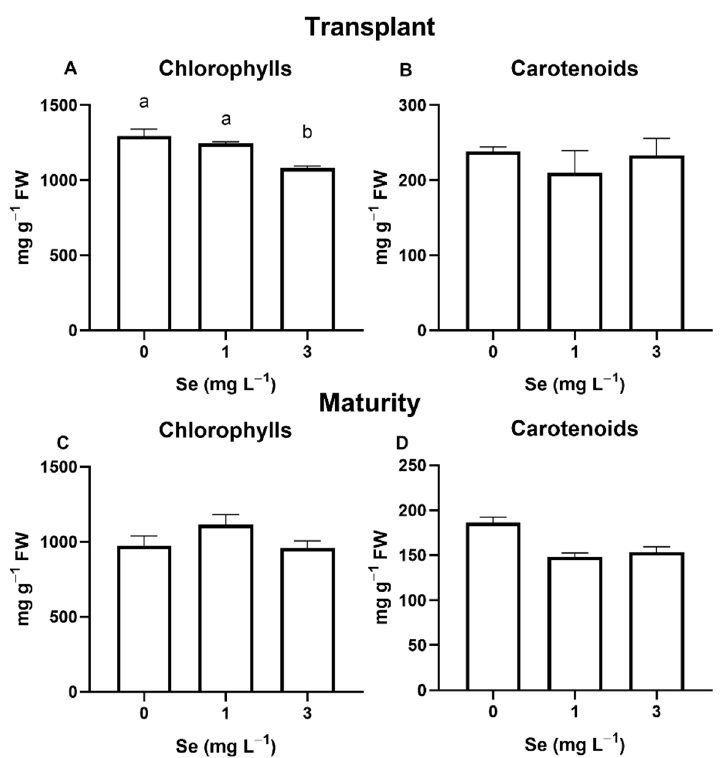
Figure 3. Total chlorophyll and carotenoid contents, measured at transplant ( A , B ) and maturity ( C , D ), in leaves of lettuce plants treated with different concentrations of Se at pre-transplanting. In subfigure ( A ), means ( n = 3) flanked by different letter are statistically different for p = 0.05 after Tukey’s test.